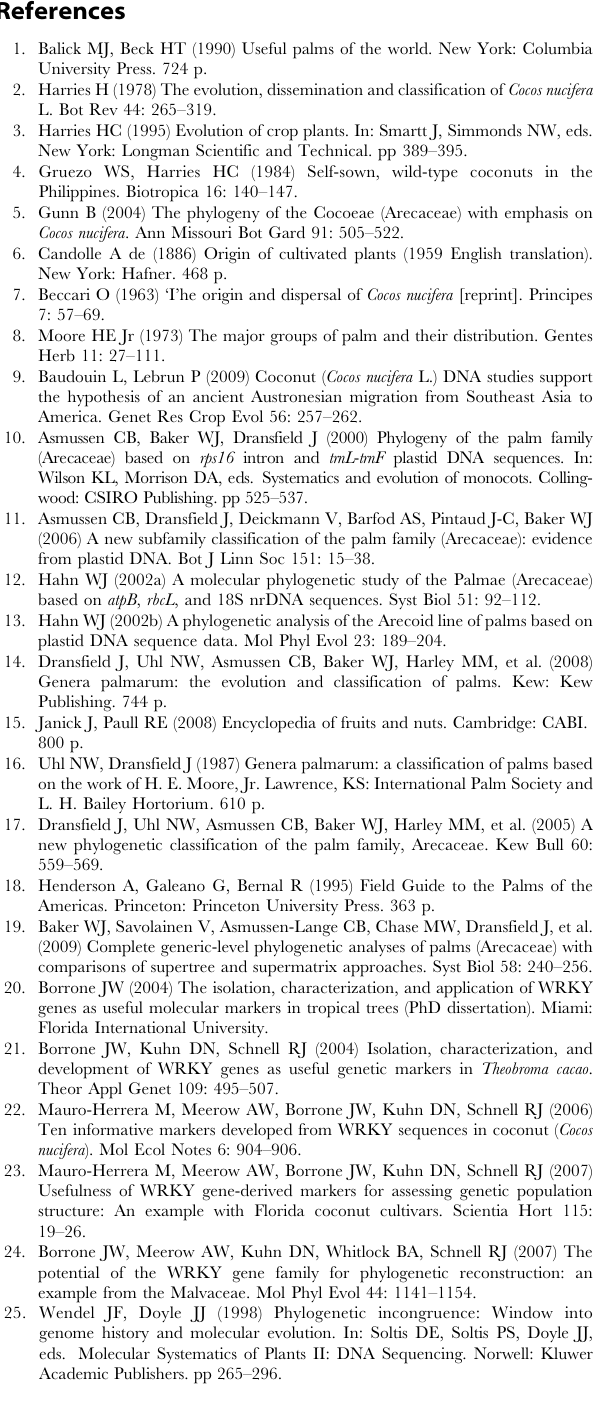
Table S2 This table lists the specific primers used to amplify and sequence the seven WRKY loci from members of Arecaceaea tribe